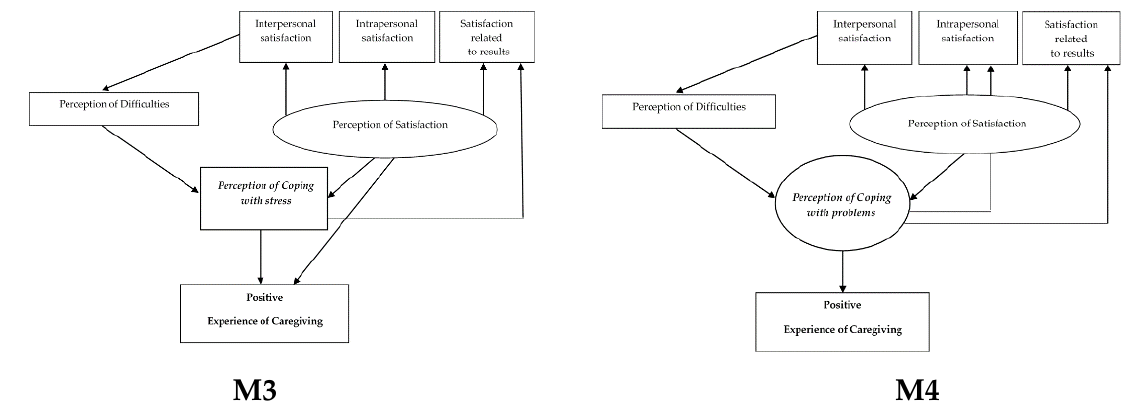
Figure 2. Hypothesized theoretical models for positive experience of caregiving.